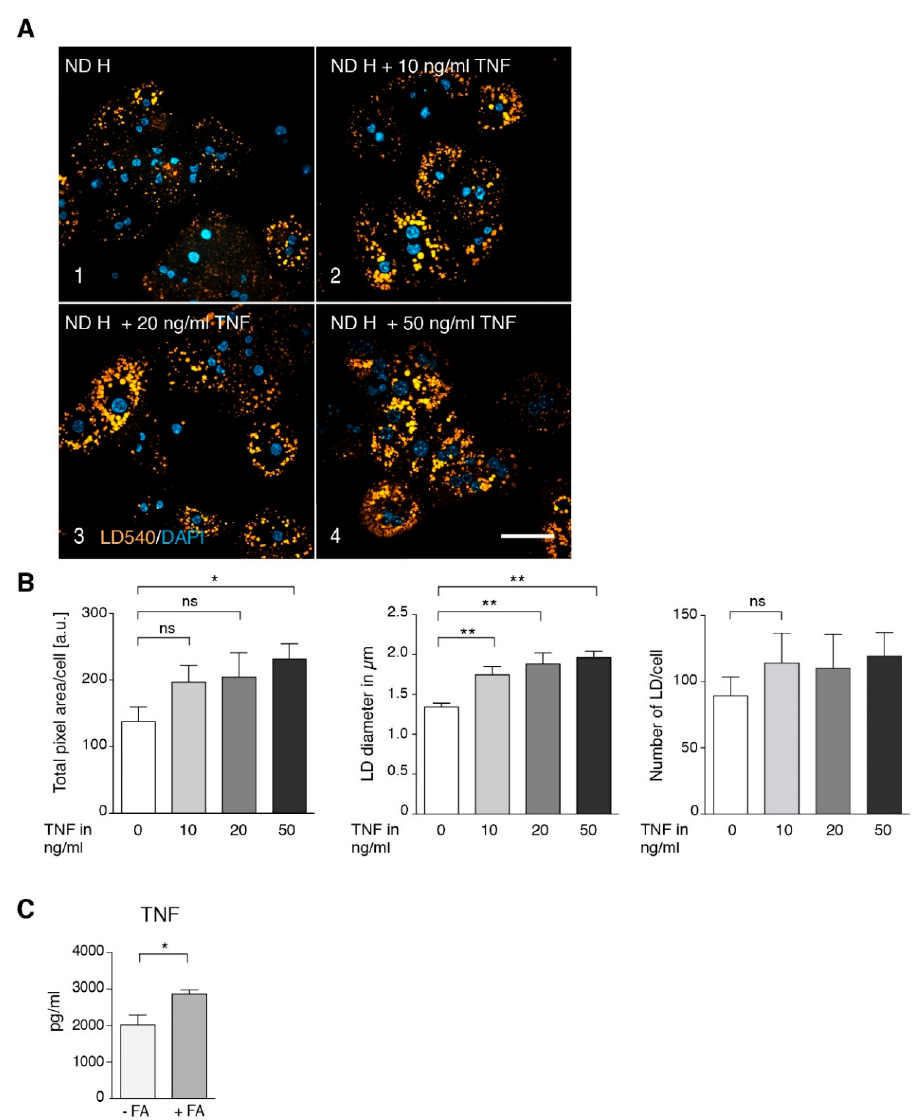
Figure 4. Influence of TNF on lipid droplet size and number in normal diet hepatocytes. Primary hepatocytes from ND mice were isolated and treated with different concentrations of TNF for 2 h. ( A ) Staining for lipid droplets (LD540) and nuclei (DAPI). Scale bar: 50 µm. ( B ) Quantification of total fluorescent lipid droplet (LD) area per cell, LD size in µm and number of lipid droplets/cell ( n = 6). ( C ) Secretion of TNF by isolated Kupffer cells after 16 h treatment with 0.5 mM FFA. Data are represented as mean value with SEM. Significance was analyzed with a two-tailed Student’s t-test. Statistical significance is indicated as follows: ns, not significant, * p < 0.05, ** p < 0.01.